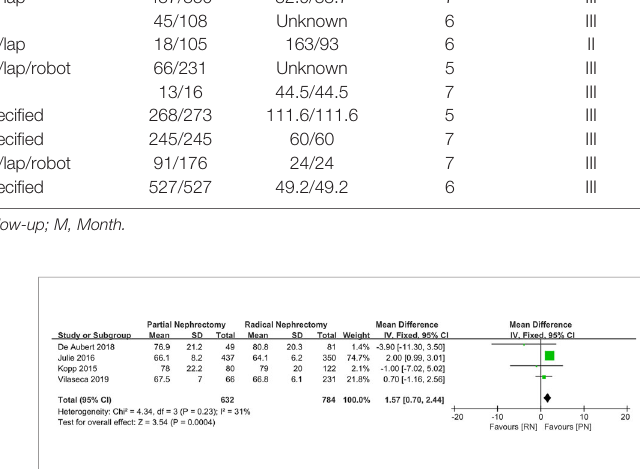
FIGURE 5 | Preoperative eGFR.